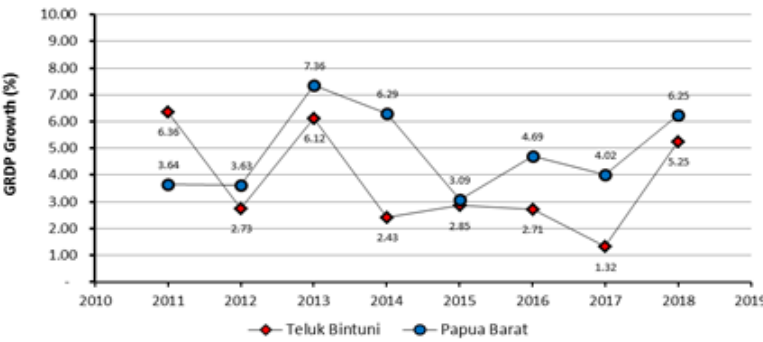
Figure 2: Comparison of GRDP Growth between Teluk Bintuni Regency and Papua Barat Province Source: BPS